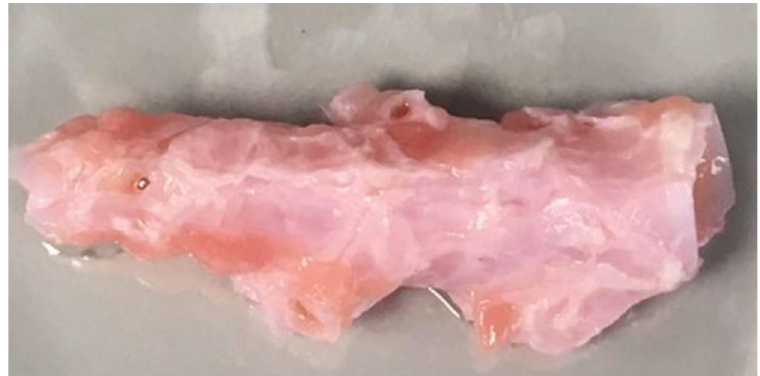
Figure 3. Ex vivo porcine bronchiole. A single bronchiole excised from porcine lung tissue after cleaning and a single wash in DMEM/RPMI solution. All alveolar and vascular tissue was removed using a razor blade and dis- section scissors. After cleaning, bronchiole tissue was cut into 5 mm (cid:1) 5 mm squares for use as solid substratum to promote biofilm